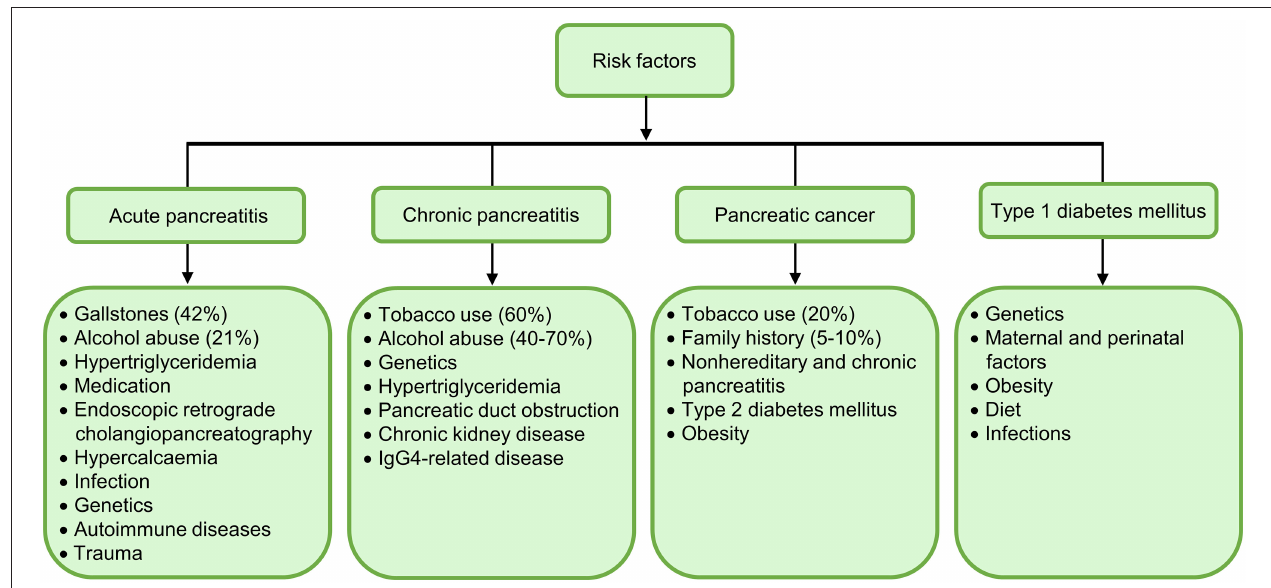
FIGURE 1 | Summary of major aetiological risk factors for acute pancreatitis (AP), chronic pancreatitis (CP), pancreatic cancer, and type 1 diabetes mellitus (T1DM). Gallstones (42%) and alcohol abuse (21%) are the most frequent etiologies of AP; while tobacco use (60%) and alcohol abuse (40–70%) are the top aetiological factors of CP. Cigarette smoking (20%) and family history (5–10%) are dominant aetiological risk factors for pancreatic cancer. It is of note that alterations in oral microbiome predispose patients to pancreatic cancer. Genetics and environmental factors collectively contribute to the onset of T1DM, but other independent risk factors are unclear.